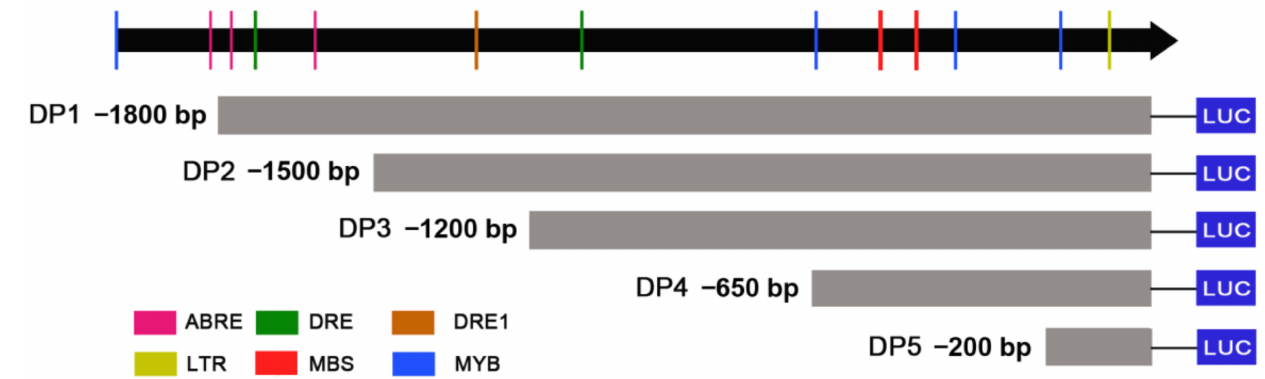
Figure 7. Schematic diagram of the different truncated fragments of ZmDi19-5